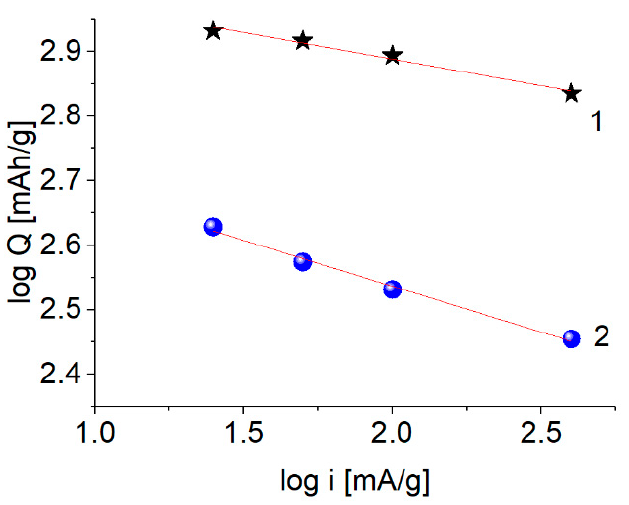
Figure 9. The capacity vs. current density dependence for insertion of lithium (1) and sodium (2) .